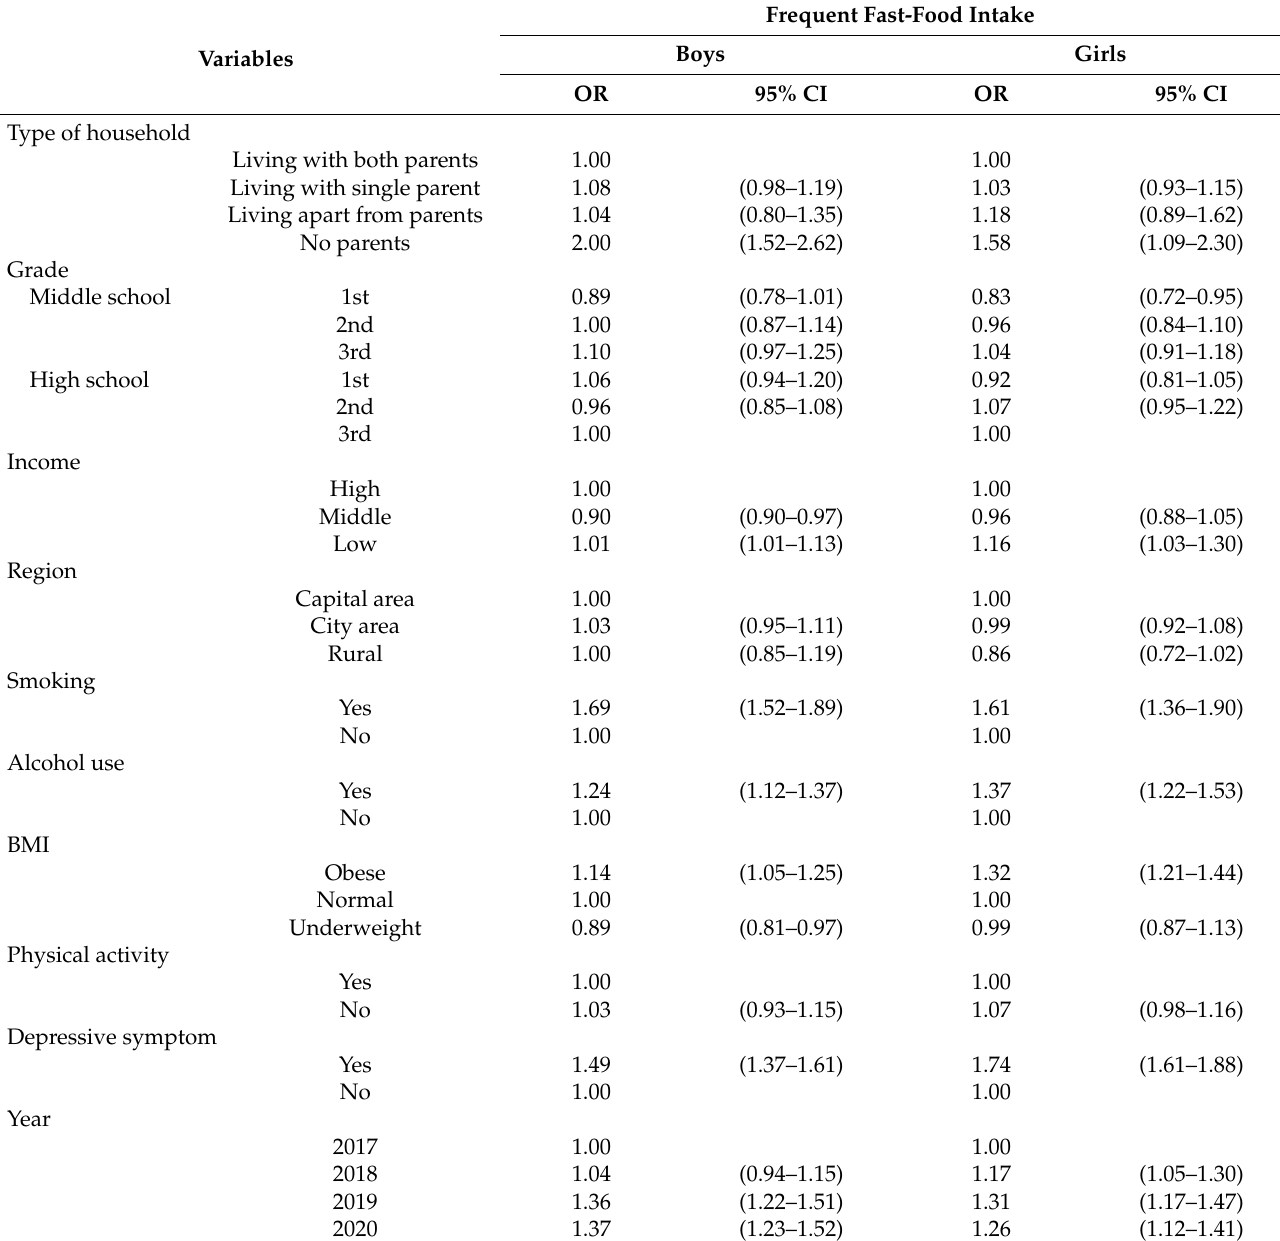
Table 2. Results of factors associated with fast food